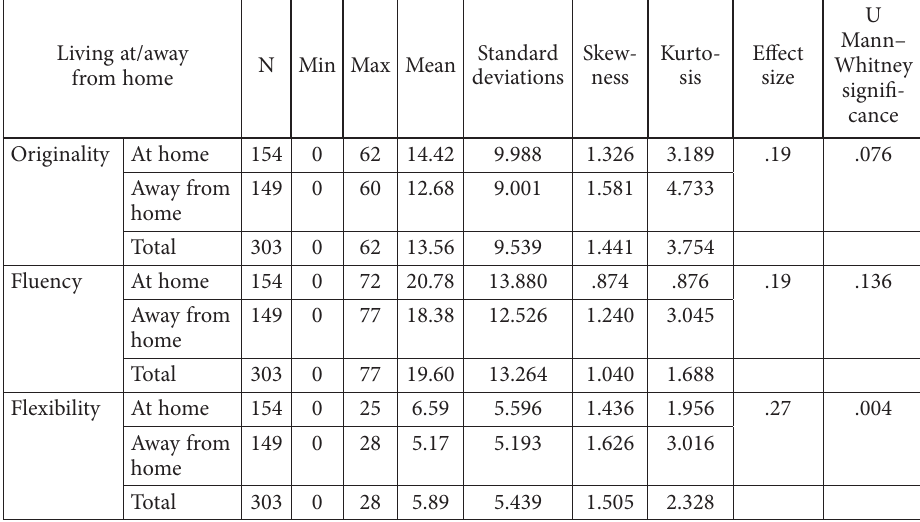
Table 5. Frequencies for creative potential (Runco Ideational Behavior Scale: short form) based on employment status and the results of Student’s t-test (source: created by authors) Employ- ment Runco Ide- ational Be- havior Scale: short form (RIBS-sf)